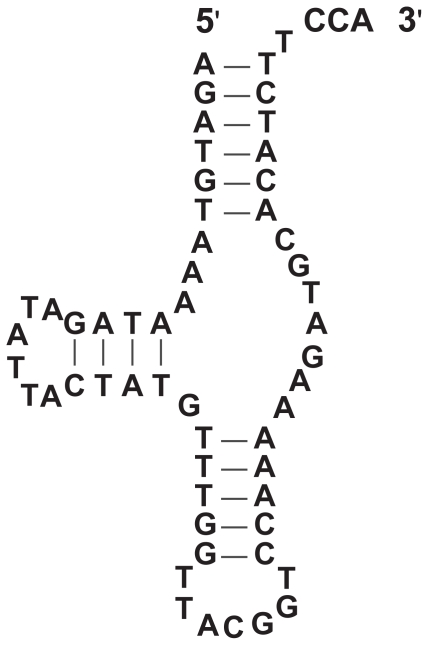
The two-arm, tRNA-Arg molecule in Caenorhabditis elegans (Okimoto and Wolstenholme, 1990).